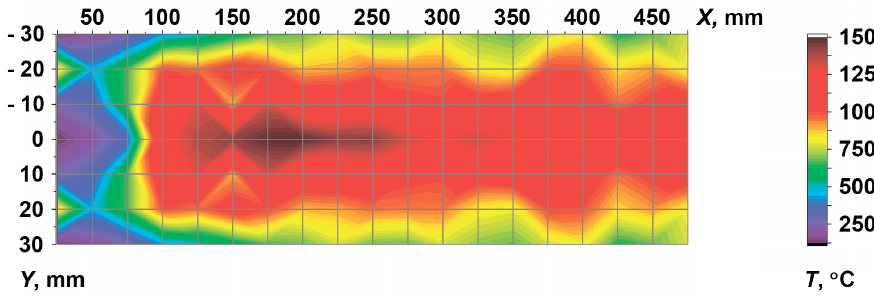
Figure 13. Temperature field in the cross-section of the diesel